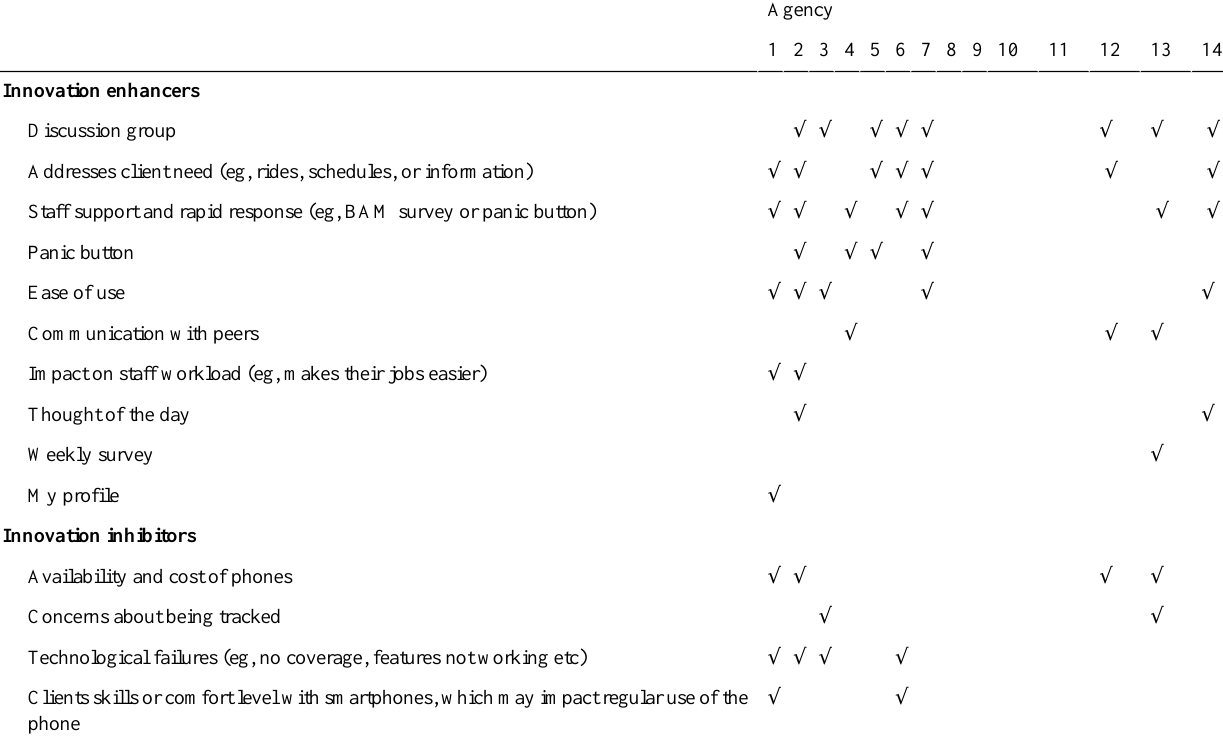
Table 5. Attributes of the A-CHESS innovation potentially impacting